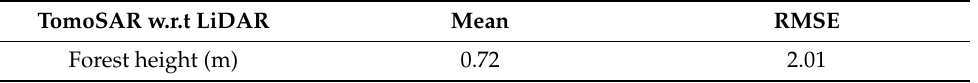
Table 6. Mean and RMSE of the forest height estimated by RIAA with respect to the LiDAR